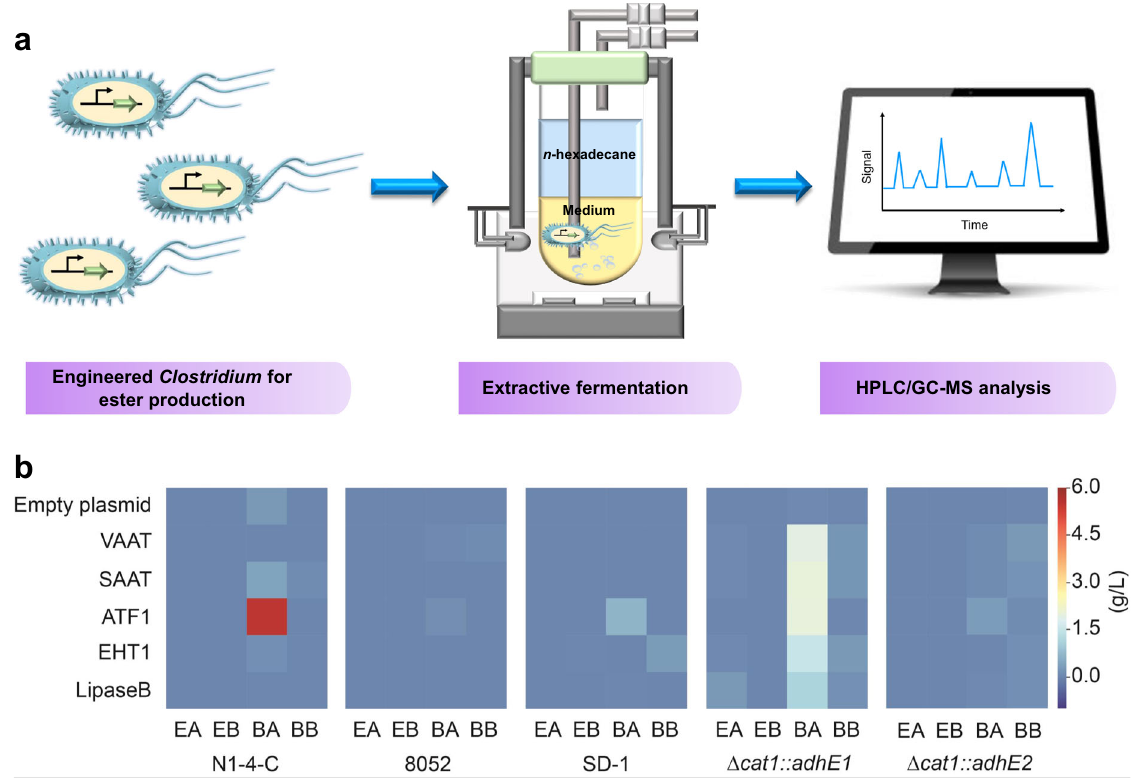
Fig. 2 Screening of strains and enzymes for ester synthesis. a Schematic representation of procedures for extractive ester fermentation. b Heatmap results showed the ester production in various Clostridium strains with the overexpression of different enzymes. Empty plasmid: expression of pMTL82151 (for C. saccharoperbutylacetonicum N1-4-C, C. pasteurianum SD-1, C. tyrobutyricum cat1::adhE1 and cat1::adhE2 ) or pTJ1 (for C. beijerinckii 8052) as the